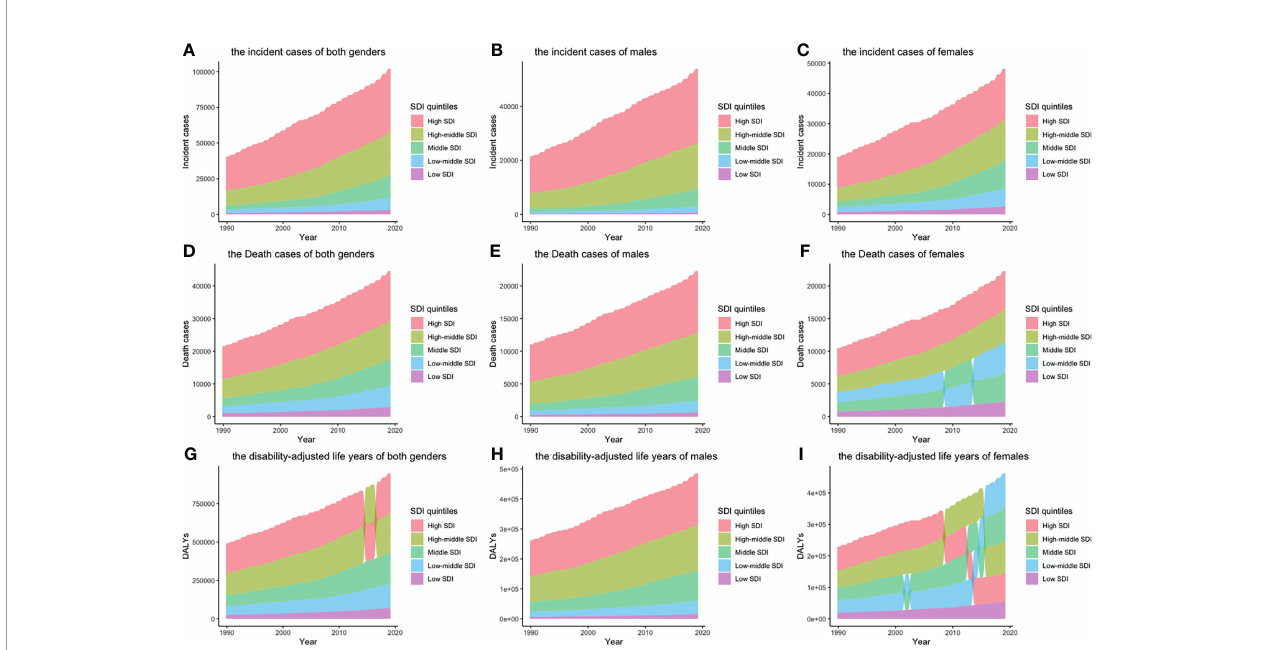
FIGURE 1 | Incident cases, death cases, and DALYs of different SDI quintiles from 1990 to 2019 by gender: (A) incident cases of both genders; (B) incident cases of males; (C) incident cases of females; (D) death cases of both genders; (E) death cases of males; (F) death cases of females; (G) DALYs of both genders; H: DALYs of males; I: DALYs of females. Alluvia represent numbers of different SDI quintiles, from the highest (the SDI quintile with largest number) to the lowest (the SDI quintile with smallest number). (DALY, disability-adjusted life year; SDI, socio-demographic